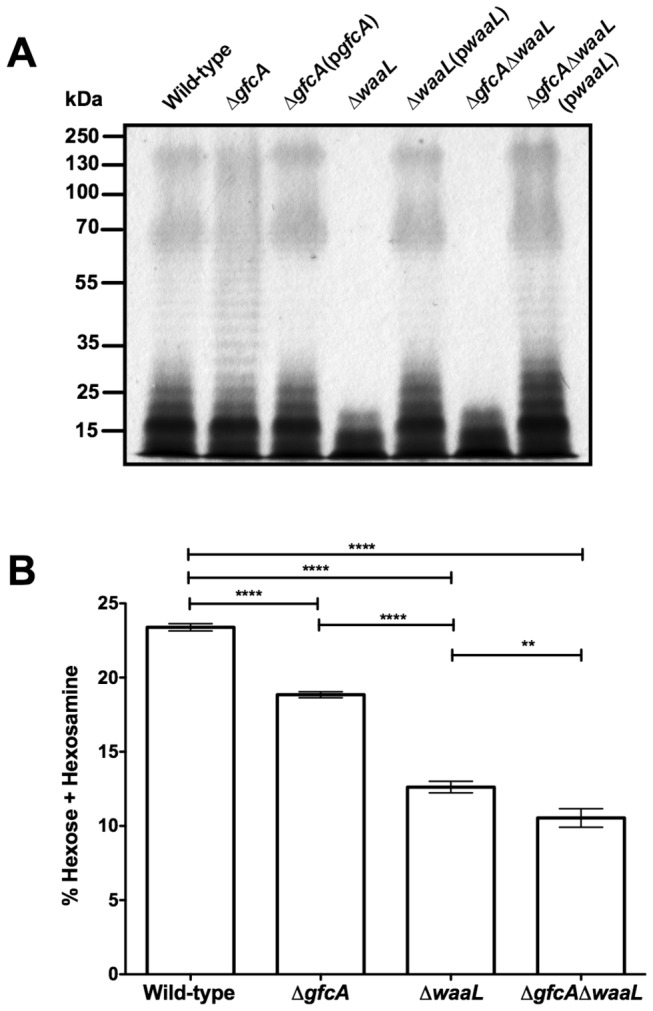
Interplay between G4C and O-antigen.(A) Silver staining of proteinase K-treated LPS of the indicated EPEC strains. All samples were normalized (by OD600) to ensure that the same number of cells was used. Data shown are representative of three independent experiments. (B) Percent of total combined hexose and hexosamine in each purified polysaccharide preparation ([mg hexose +hexosamine]/ mg purified polysaccharide) from the indicated strain. Results are expressed as mean ± SDs of samples. Asterisks indicate statistical significance; **, P<0.01; ****, P<0.0001 by one-way ANOVA and Bonferroni’s post
hoc comparison test.